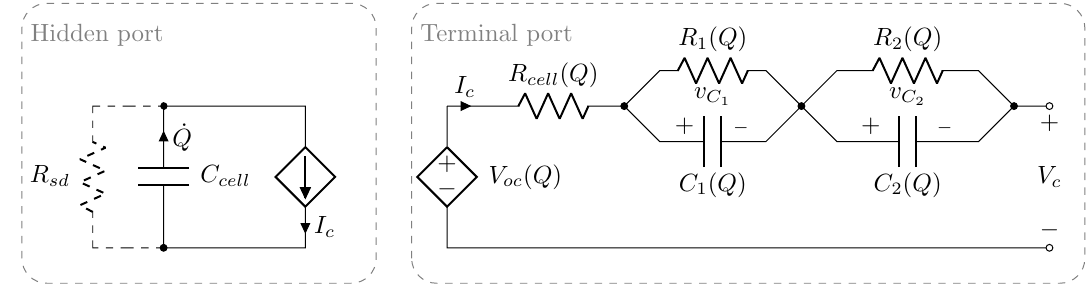
Figure 10. Equivalent circuit model (adapted from